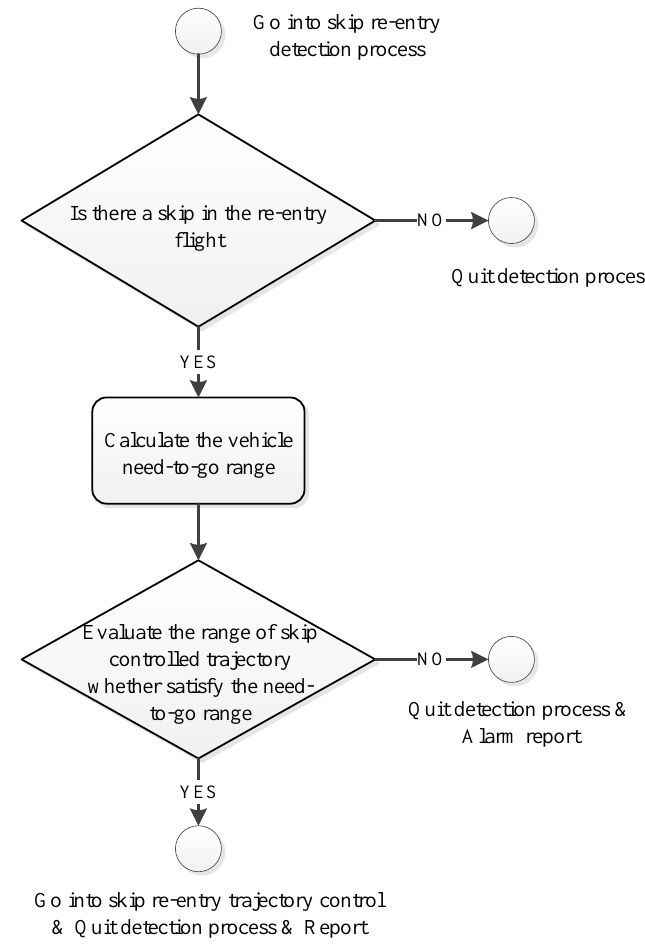
Figure 3. Skip detection for trajectory control logic.